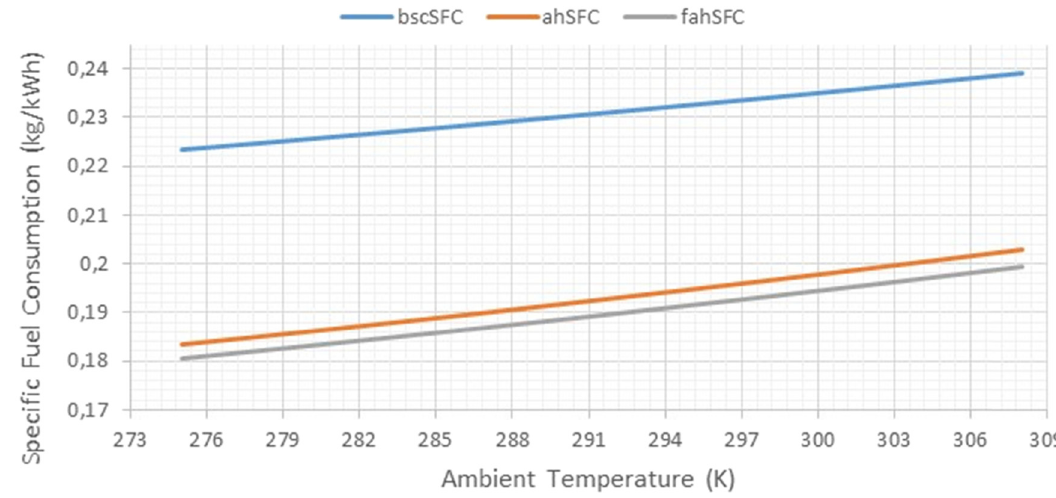
Figure 8: Variation of the SFC with the ambient temperature for bsc, ah and fah cogeneration